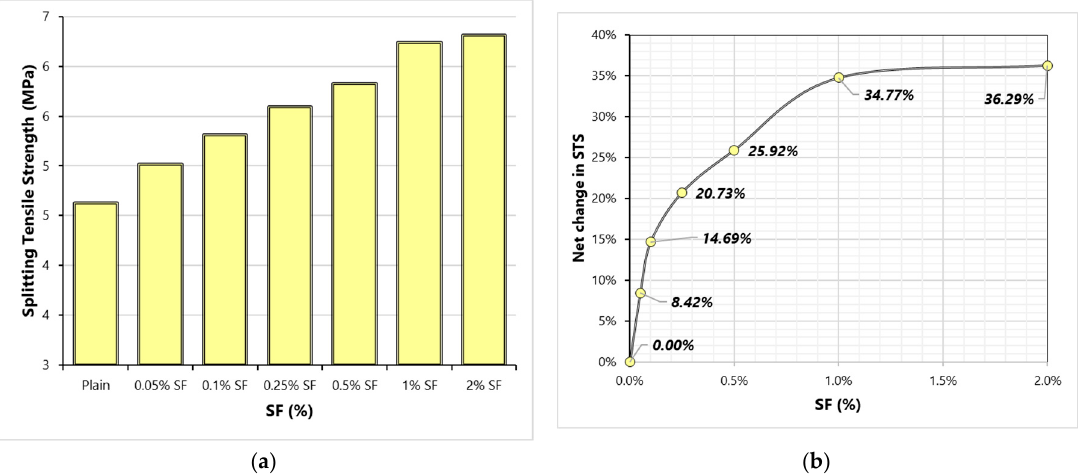
Figure 8. Splitting-tensile strength (STS) results ( a ) Variation of STS with SF dosage ( b ) Net change in STS with varying SF dosage.